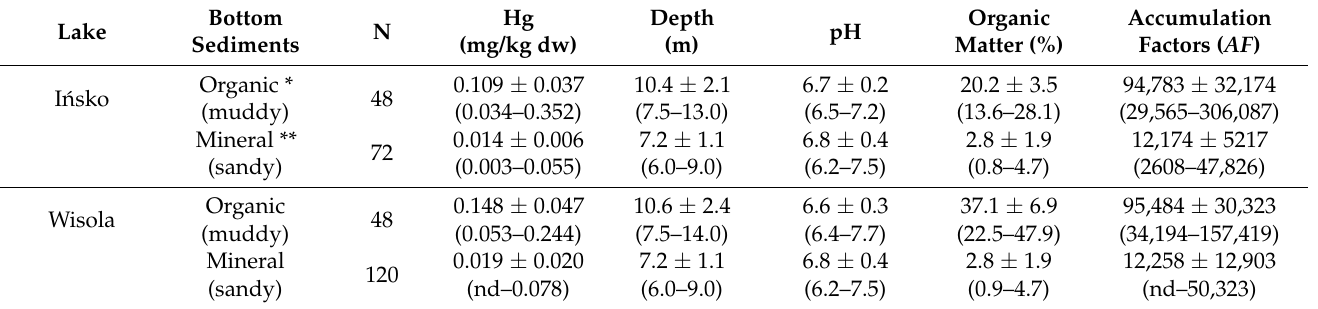
Table 3. Mercury content and other parameters of bottom sediments from lakes I´nsko and Wisola (mean ± SD; min–max).